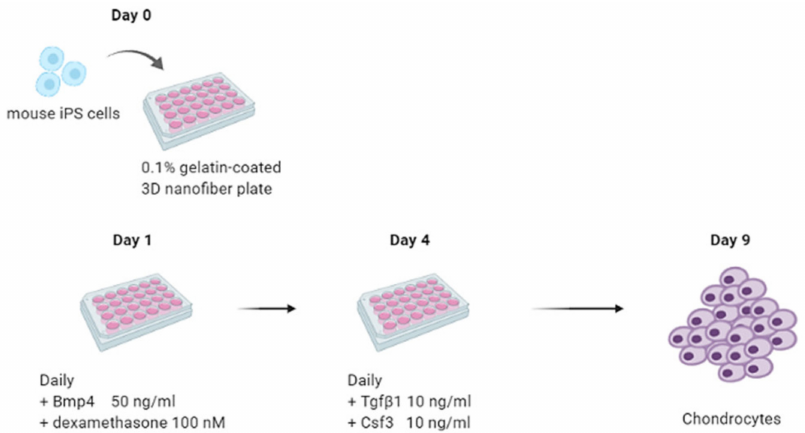
Figure 5. Schematic of our 3D nanofiber chondrogenic differentiation strategy. Single cell